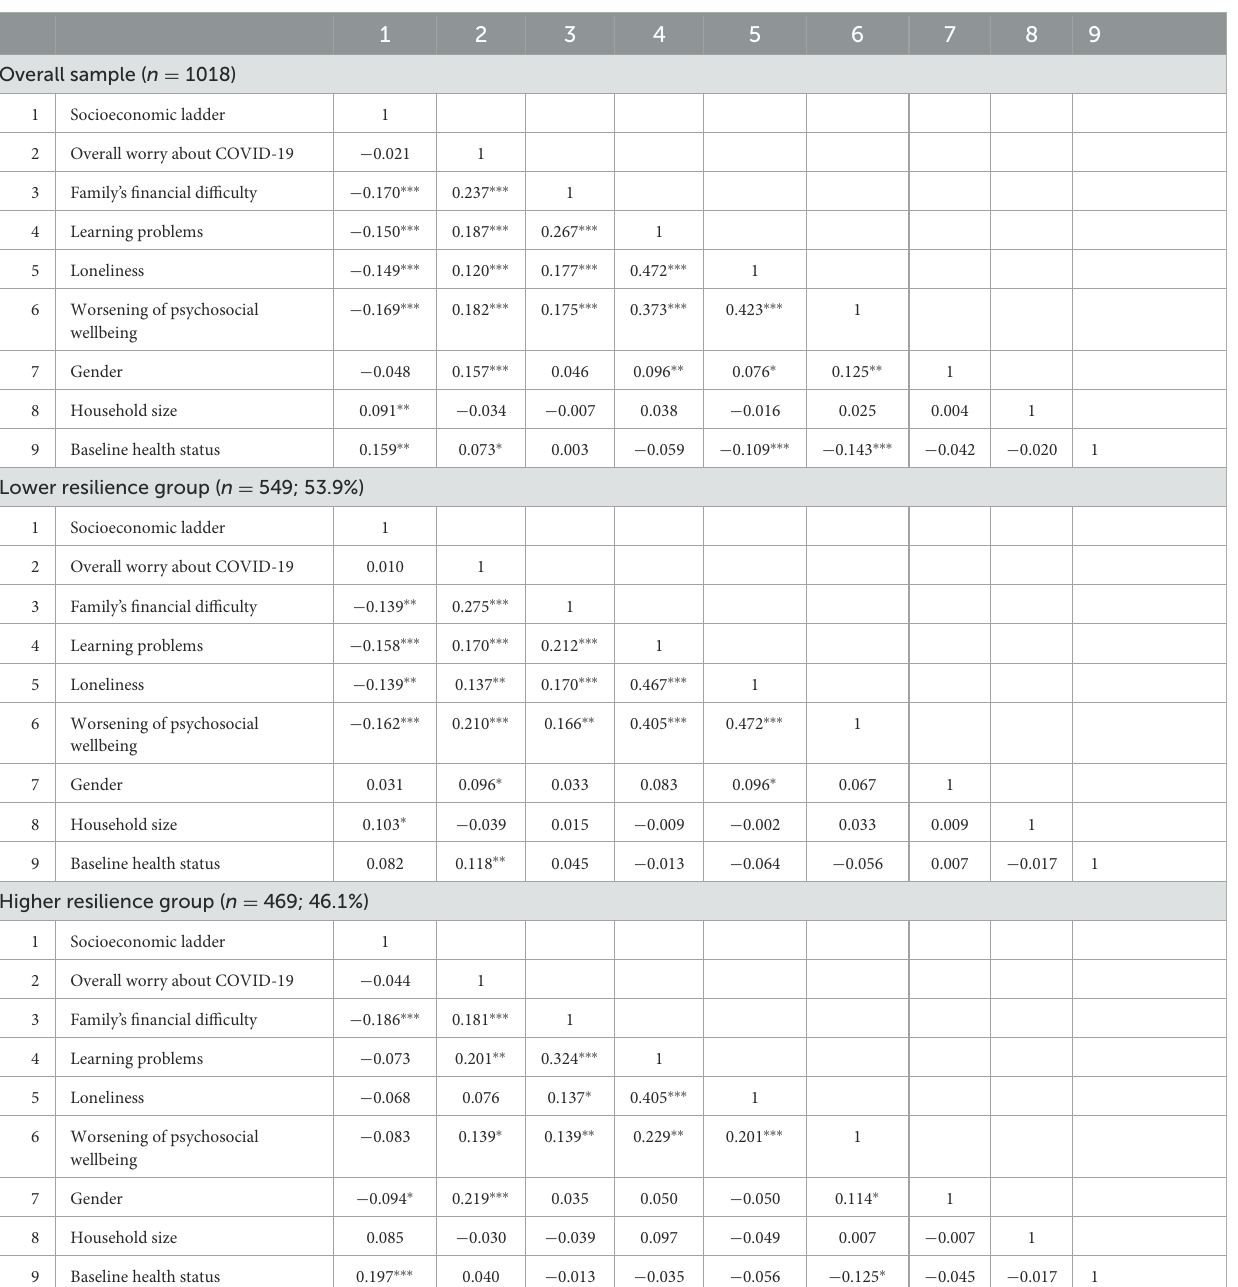
TABLE 3 Correlation matrix among observed